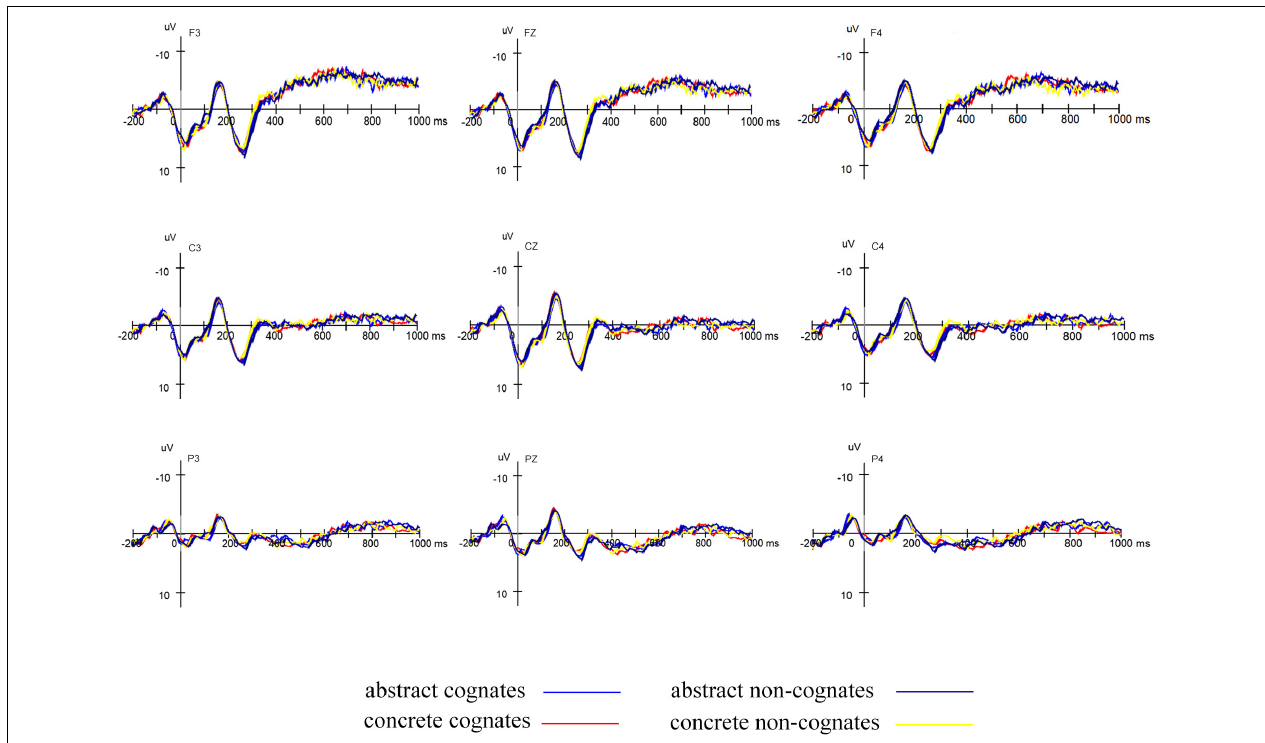
FIGURE 3 | Grand average ERPs elicited by targets primed by abstract cognates, abstract non-cognates, concrete cognates, and concrete non-cognates in L2–L1 translation direction.